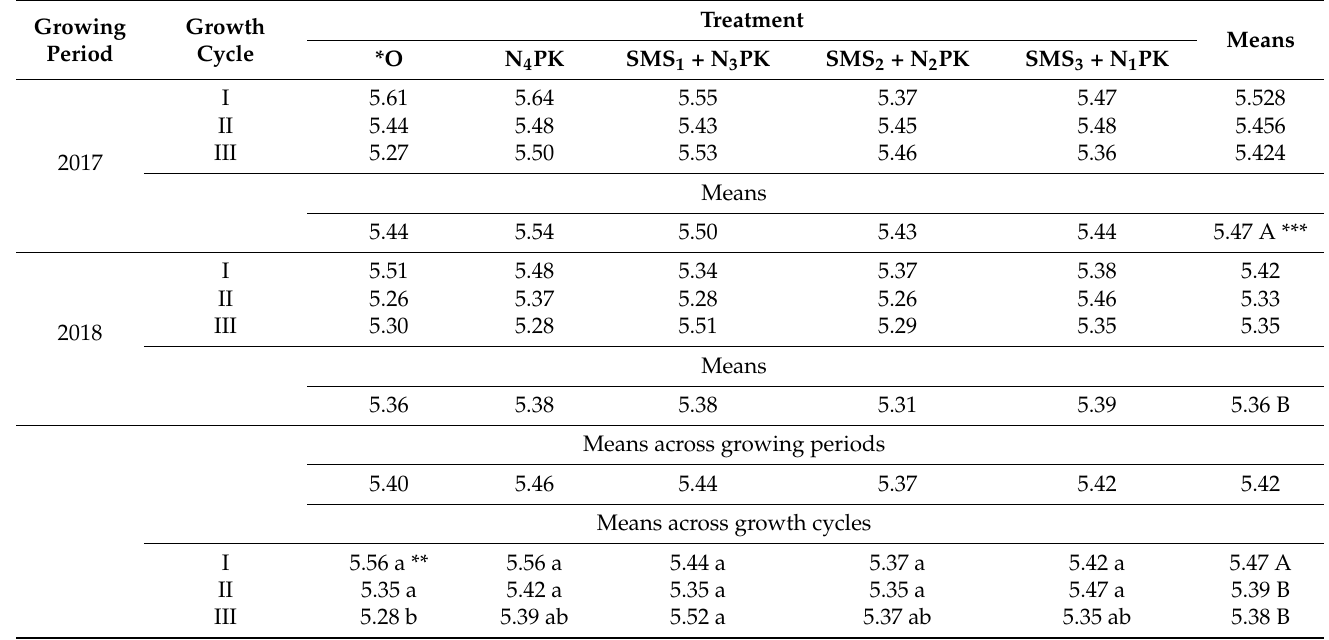
Table 7. The effect of fertilizer treatment, growing period and growth cycle on Festulolium braunii net energy of lactation (MJ · kg − 1